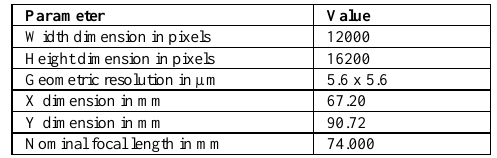
Table 2. The synthetic image main parameters.